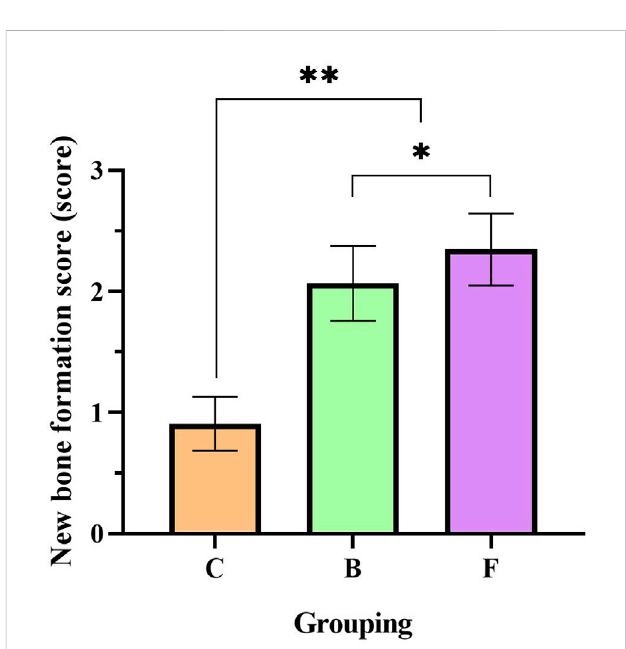
FIGURE 15 New bone formation score for femoral repair at 4 weeks. (C: Self- healing group; B: BDBM group; F: FDBM group) (**: Signi fi cant difference compared to the self-healing group, p < 0.01; *: Signi fi cant difference compared to BDBM, p <